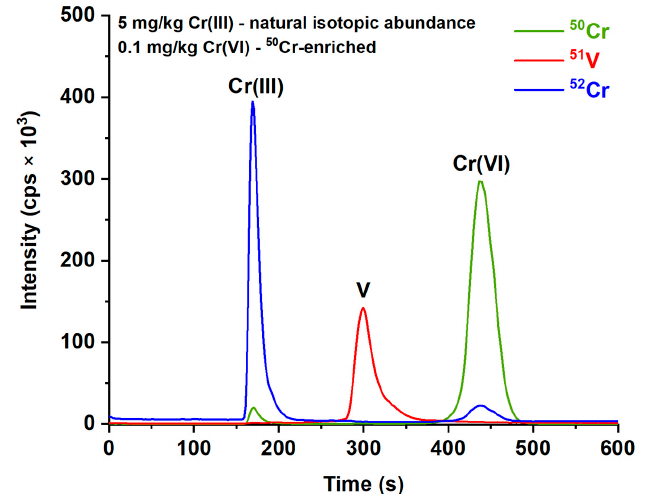
Figure 1. Chromatographic profiles obtained in optimized conditions for a 5 mg/kg Cr(III) + 100 ppb 50 Cr(VI) standard solution, with 100 ppb of Vanadium used as internal standard. Green, red and blue profiles represent the signals recorded at m/z 50, 51, and 52, respectively.